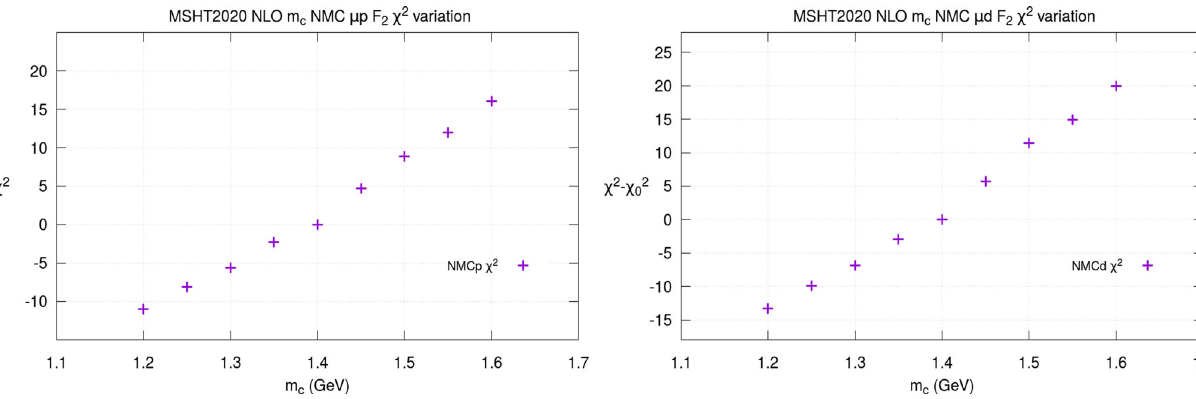
( x , Q 2 ) data and (right) the F d